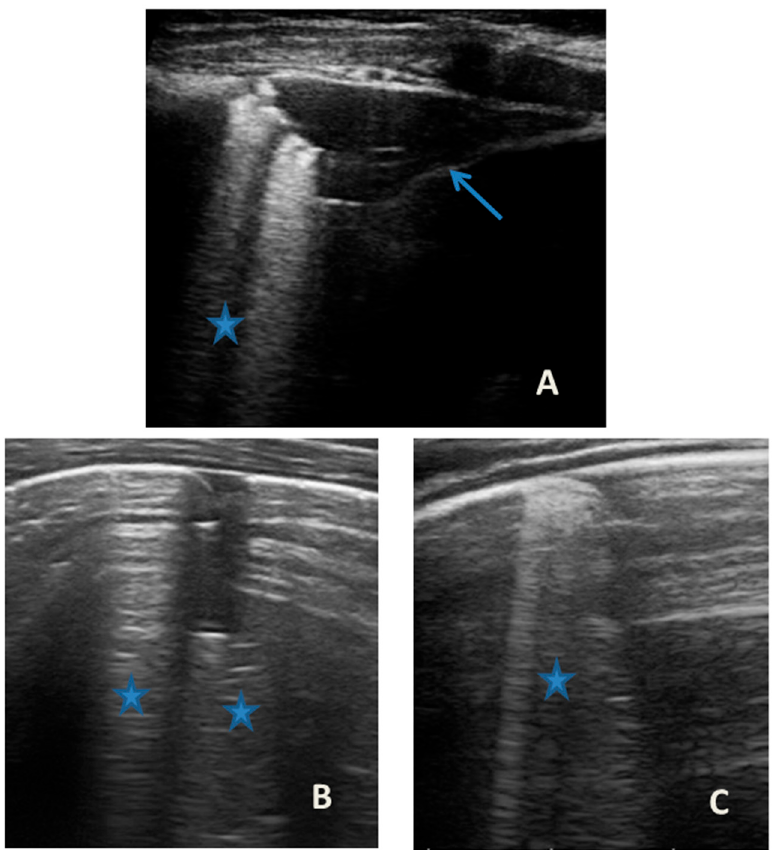
Figure 5. Grayscale lung ultrasound examination shows: an irregular pleural line in all fields explored; on the right anterior field, mainly in the medio-apical area, in the paracardiac area ( A ); and on the right anterior field in the basal area ( B ); consolidations of an atelectasis nature (arrow) poorly aerated, associated with sonographic interstitial syndrome (SIS), represented by coalescent vertical artefacts or B-lines and “white lung” areas (asterisks), which are also present in on the bilateral lateral fields ( C ).